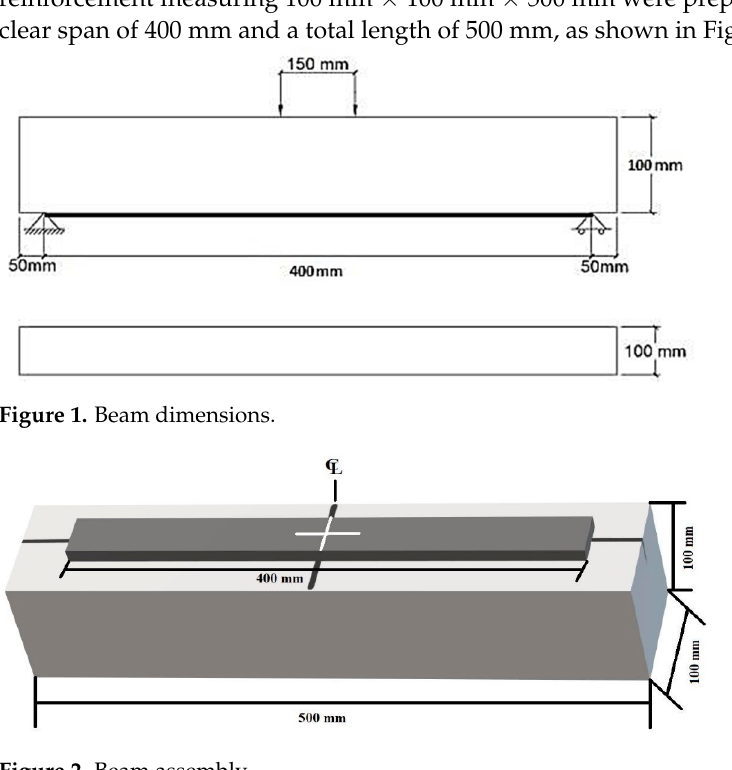
Figure 2. Beam assembly.